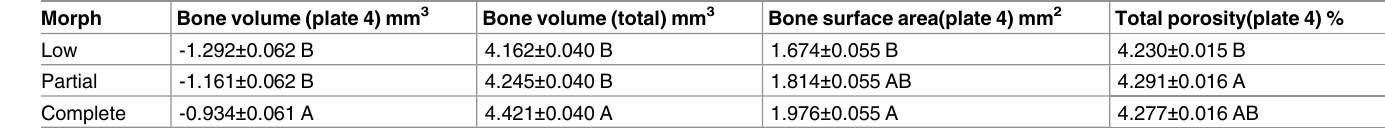
Table 3. Trait values in low, partial and complete plate morph from Asd ø ltjern and Engervann.